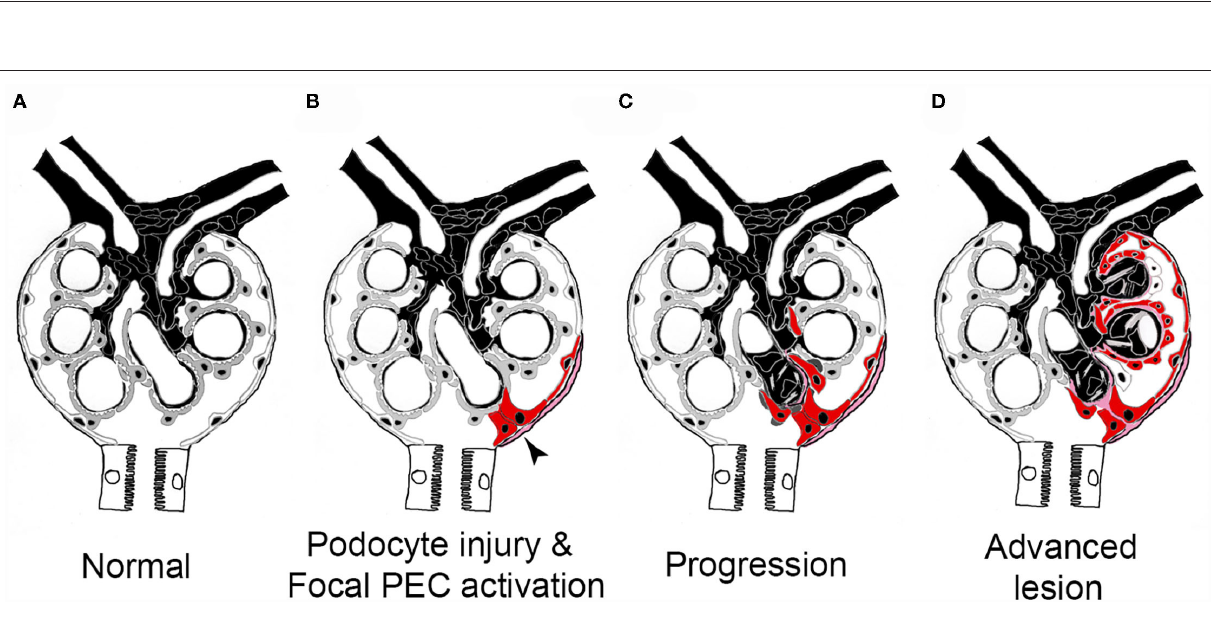
FIGURE 6 | Pathogenesis of sclerotic lesions in FSGS. (A) Normal glomerulus. gray, podocytes; white, parietal epithelial cells. (B) Podocyte injury or loss triggers focal PEC activation (red), PECs form an adhesion to the capillary tuft (arrow). (C) PECs take over parts of the capillary segment, capillaries are lost. (D) Advanced stage. Figure taken from (56) with